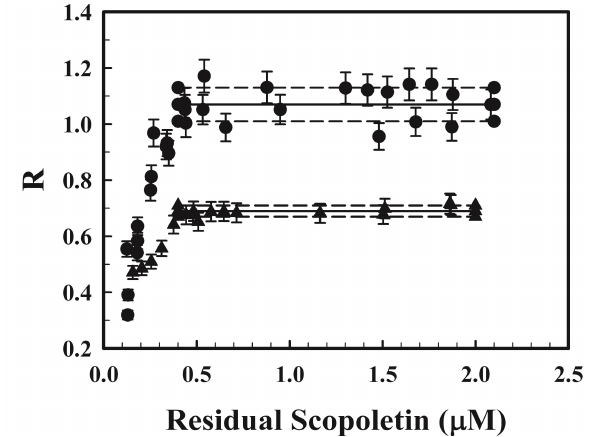
Figure 1. The effect of the concentration of residual scopoletin on the stoichiometry in the reaction between H 2 O 2 and scopoletin in reagent-grade water ( ) and in seawater ( (cid:78) ). R is the molar ratio of scopoletin lost to H 2 O 2 reacted. Duplicate samples were at least analyzed at each level of residual scopoletin. —: average R at residual scopoletin exceeding 0.4 µ M; - - -: one standard deviation from the